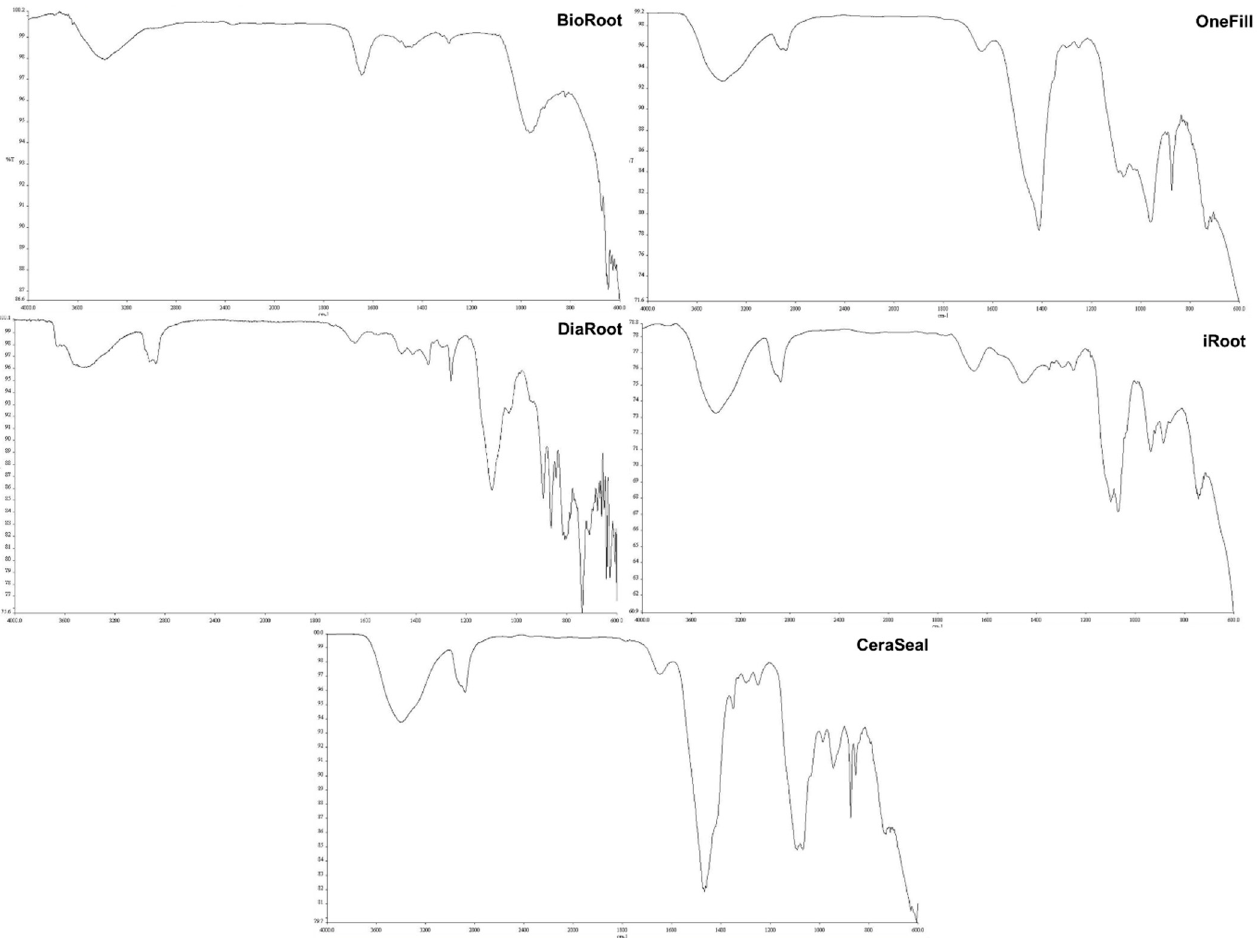
Figure 4. FTIR analysis of root canal sealers.